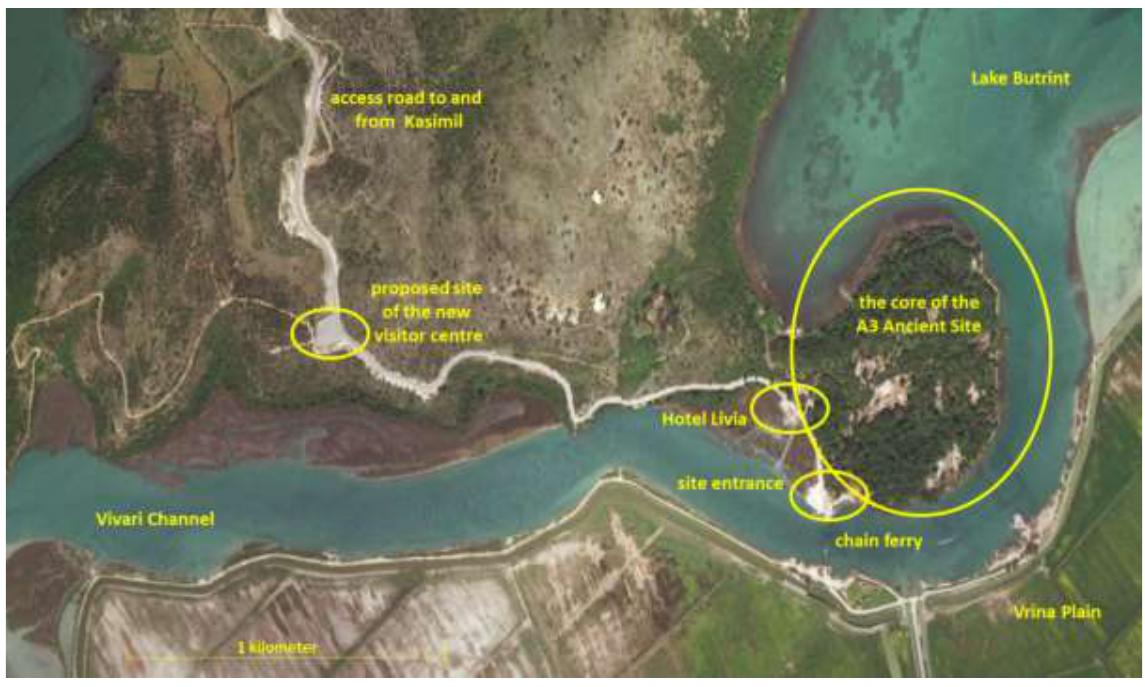
Figure 11: Primary places mentioned in the